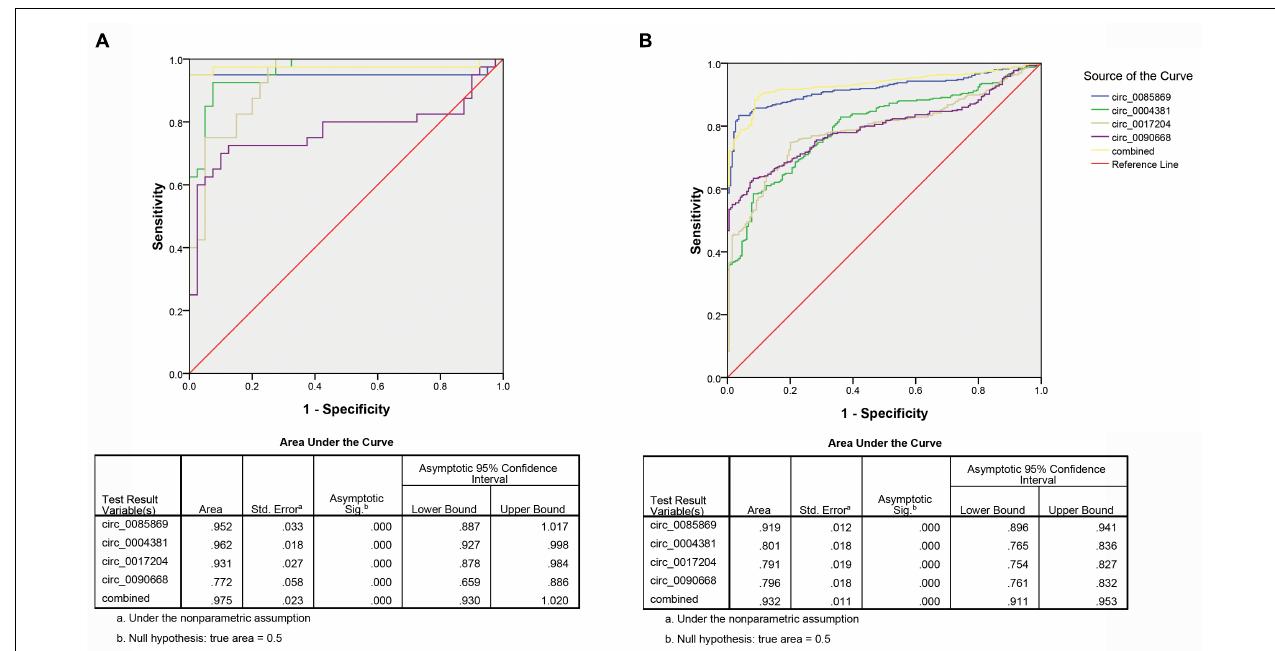
FIGURE 6 | ROC analysis of circRNA panel predicting late PD (stage 2–5) by using risk score analysis. (A) Training set. (B) Validation set.